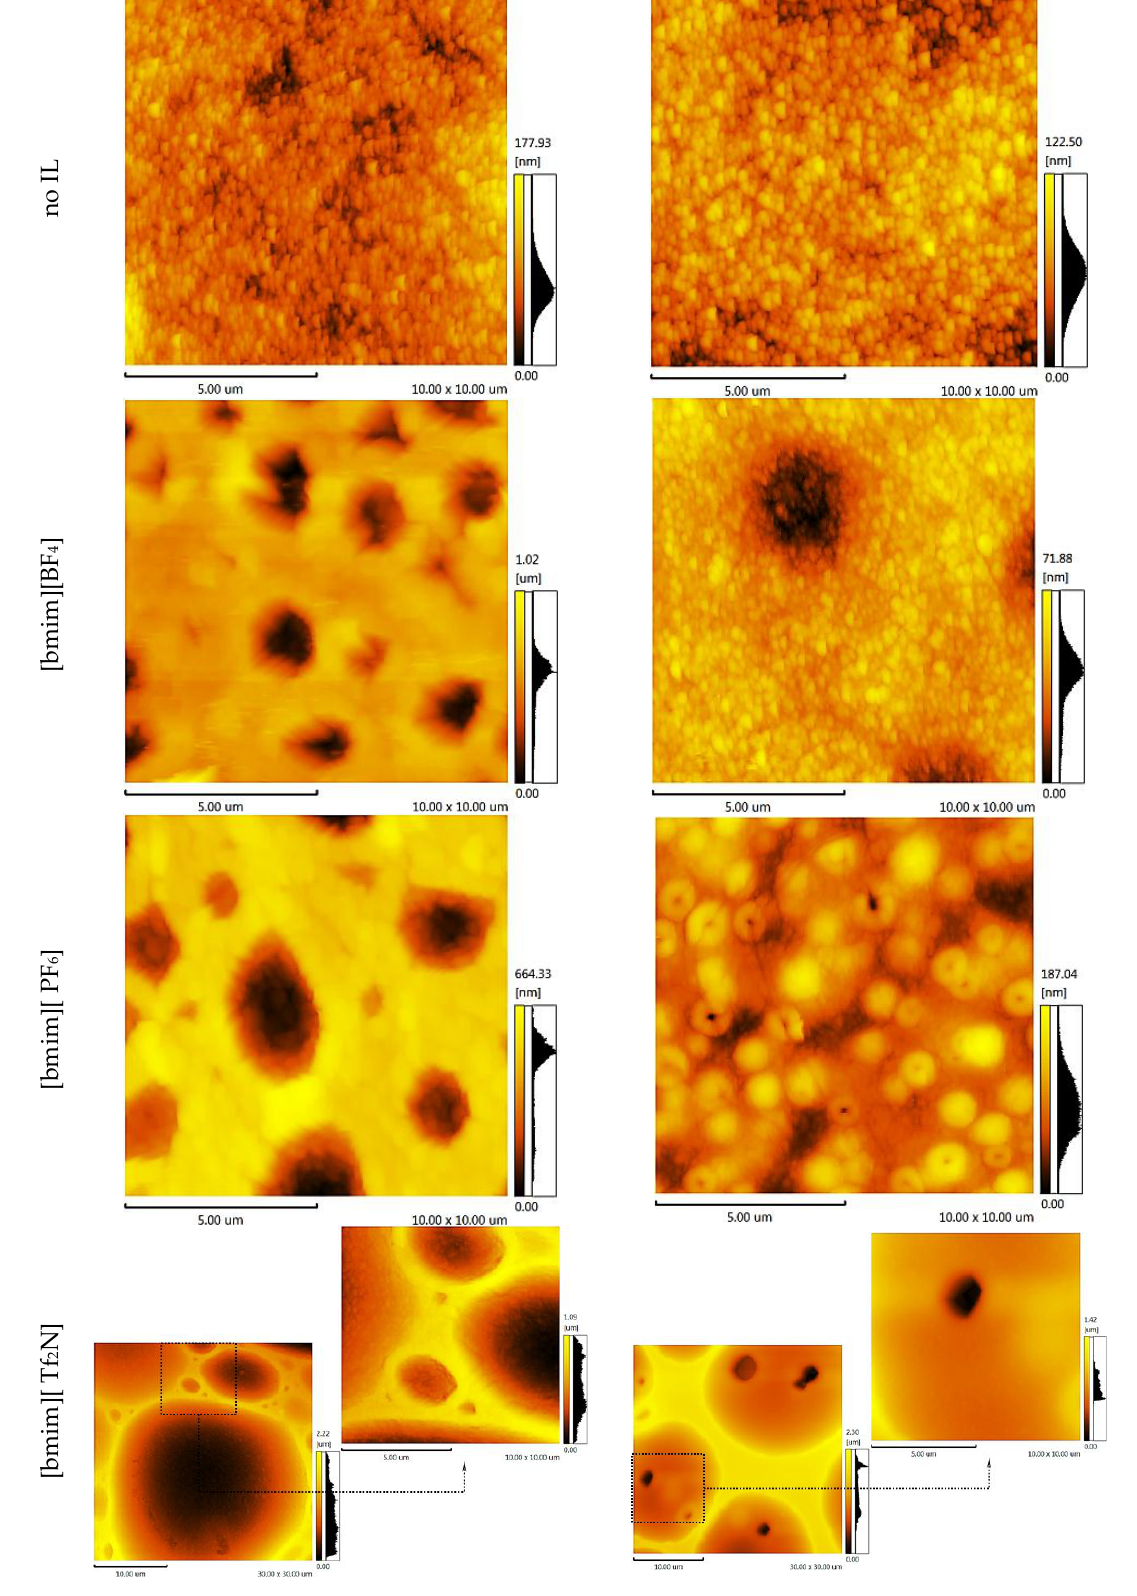
Figure 6. AFM images of the CS-PAN copolymers.